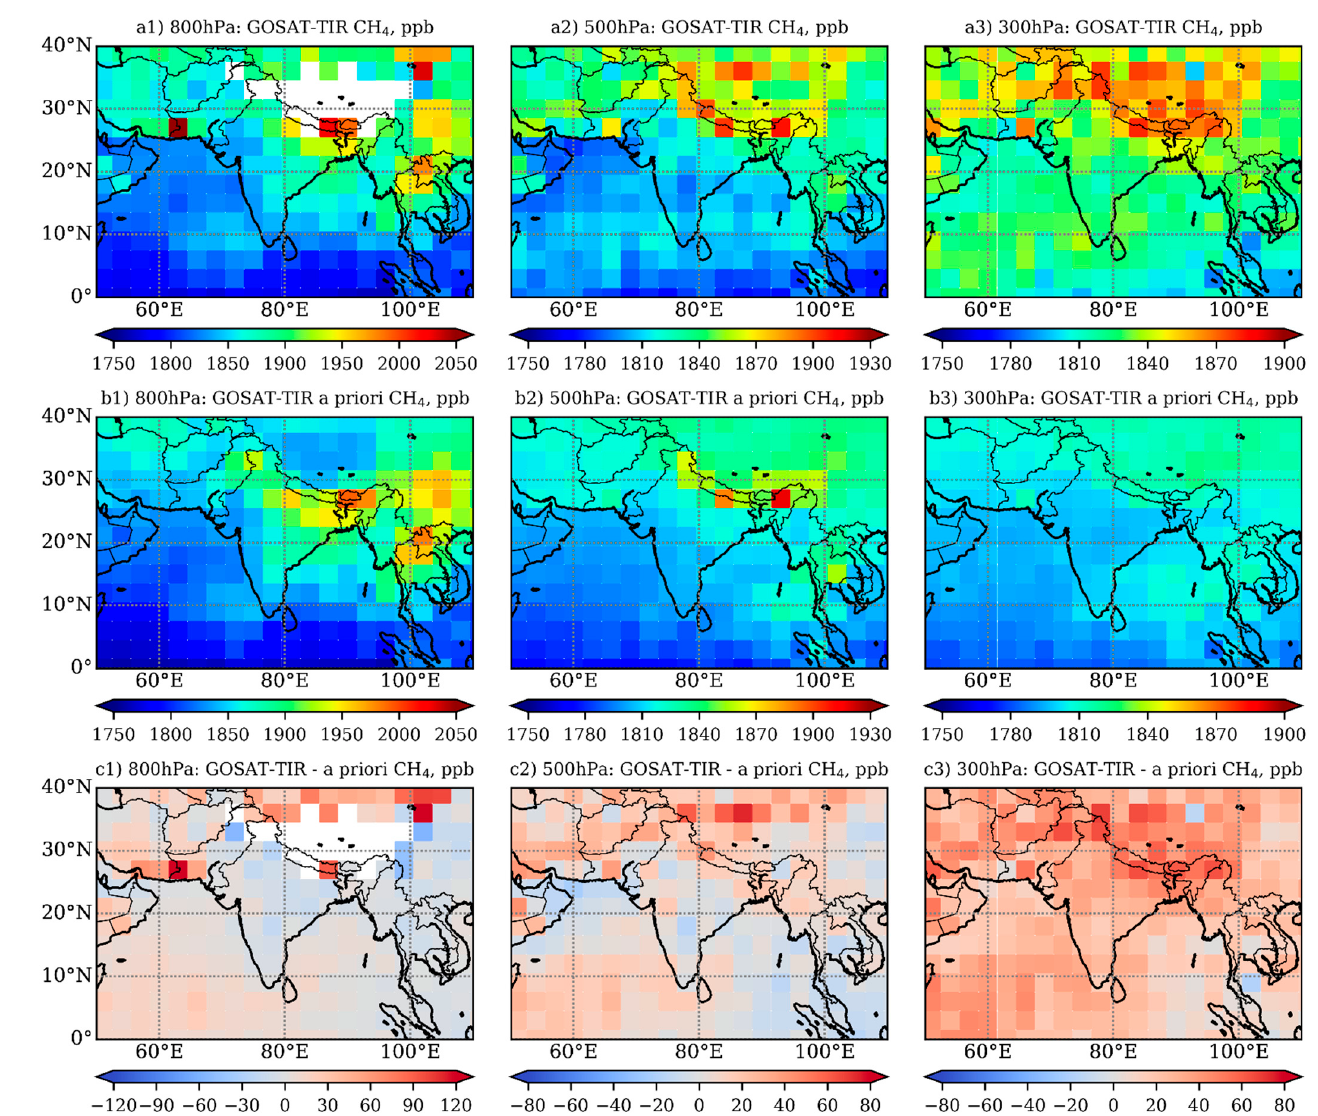
Figure 5. Latitude–longitude distributions of CH 4 at the levels of 800, 500, and 300 hPa (the left, middle, and right panels, respectively) observed by GOSAT-TIR for the season AMJ 2011. The top ( a1 – a3 ), middle ( b1 – b3 ) and bottom ( c1 – c3 ) rows show TIR CH 4 , TIR CH 4 a priori, and difference between the TIR CH 4 and a priori distributions,